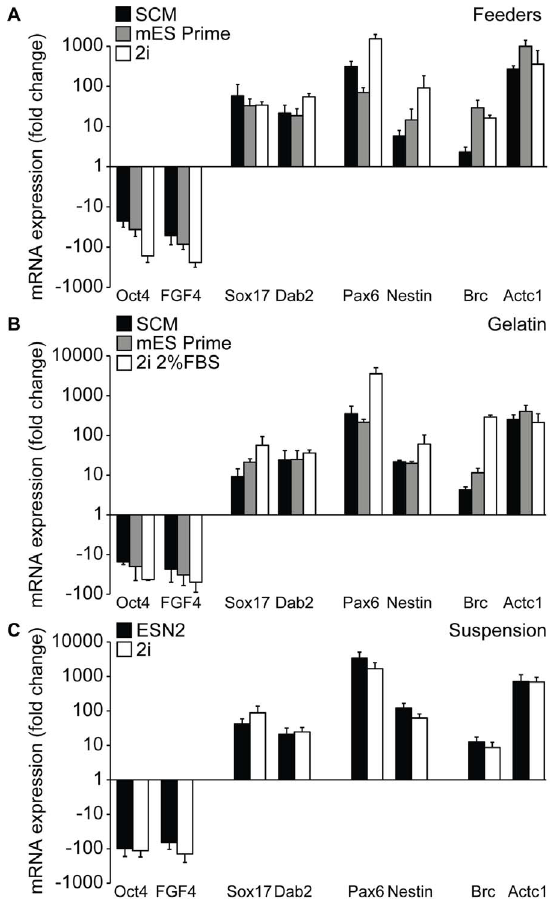
Figure 6. Analysis of ES cells induced to differentiate as assessed by quantitative PCR. Quantitative PCR analysis for the expression of Oct4 and FGF4 and indicator genes for the three germ layers in mES cells that were induced to differentiate for 6 days in SCM without LIF. Graphs represent cultures grown on feeders (A) or on gelatin (B) in SCM, mES Prime Kit or 2i media, and in suspension (C) in 2i or ESN2 media. 18S expression is used for normalization, and results are comparative (expression levels at passage 15 set as control) Ct value means 6 sd (n=3).